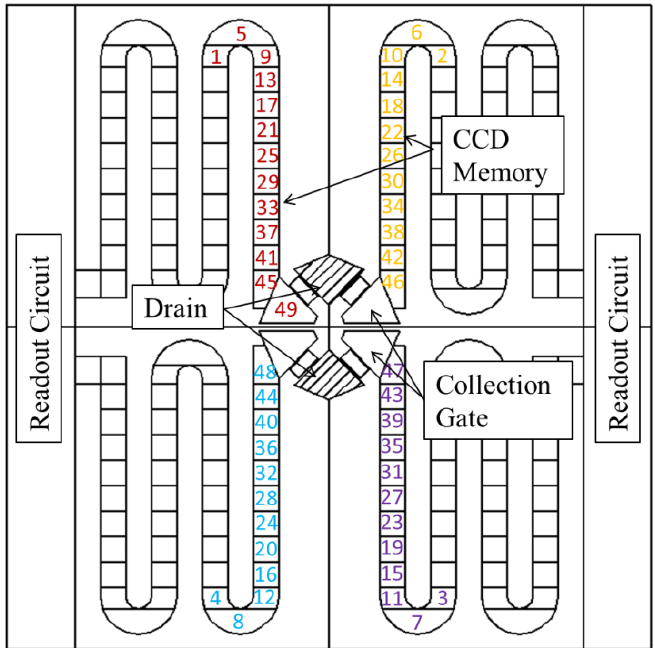
Figure 7. A tetragonal CCD multi-collection-gate image